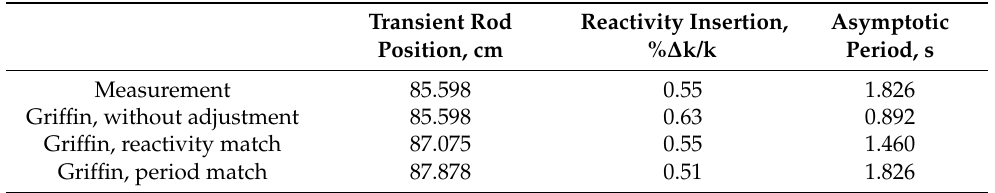
Table 6. Adjustment of initial transient rod positions to match the measured reactivity insertion and reactor period for the SIRIUS-CAL transient.